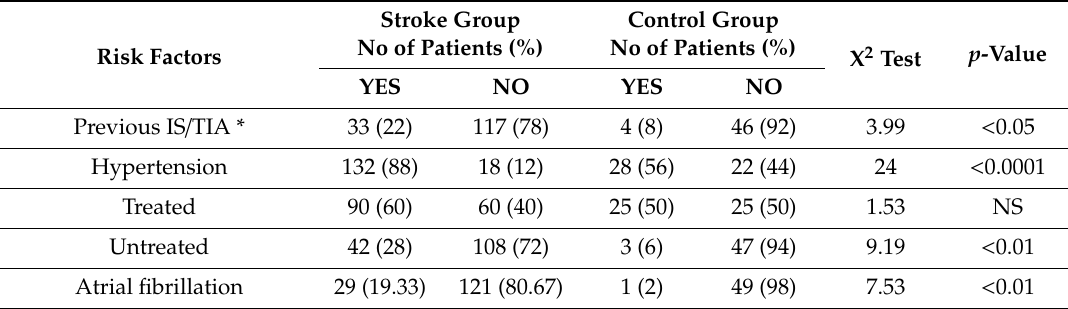
Table 2. Risk factors for an acute cerebral ischemic incident: * IS / TIA—Ischemic stroke / transient ischemic